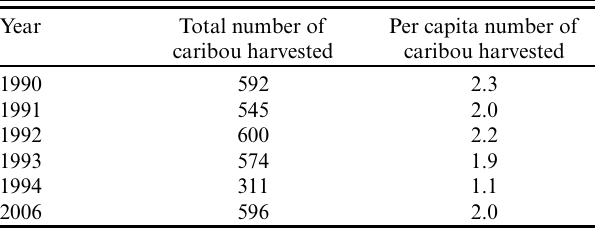
Table 2. Caribou harvests for Anaktuvuk Pass 1990–1994 and 2006. Source: Community Harvest Subsistence Information System data files (ADFG